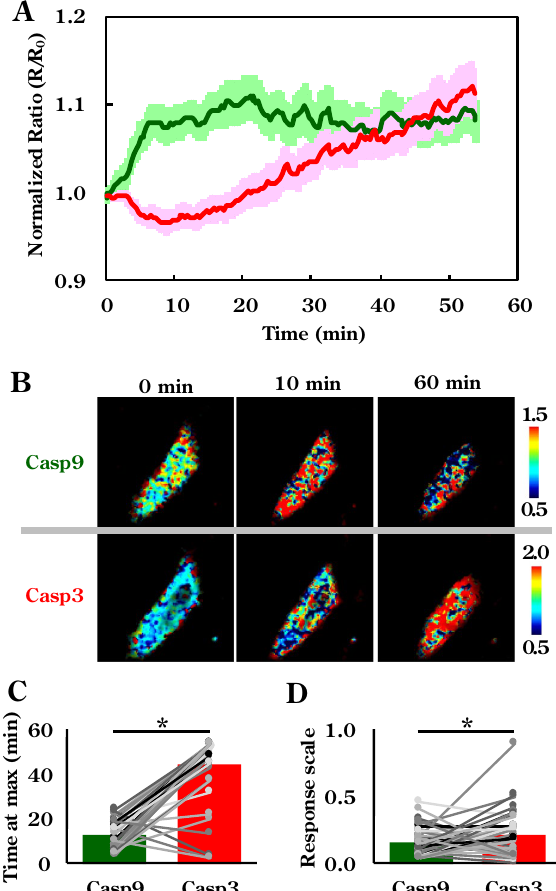
Figure 3. Simultaneous assessment of caspase-9 and caspase-3 activity in single cells undergoing apoptosis. ( A ) Averaged raw activity of individual caspases (green: caspase-9, red: caspase-3) upon apoptotic stimulation. (n = 44 cells, error bars indicate SEM) ( B ) Pseudo-colour images of the response patterns of caspase-3- and caspase-9-sensitive bioprobes at three corresponding time points. ( C ) Averaged and individual values of times at maximum activity for respective caspases. ( D ) Averaged and individual values of response scale for respective caspases. (n = 44 cells, bar graphs indicate the average, dots and bars indicate the values of each cell, * indicates P < 0.05 by